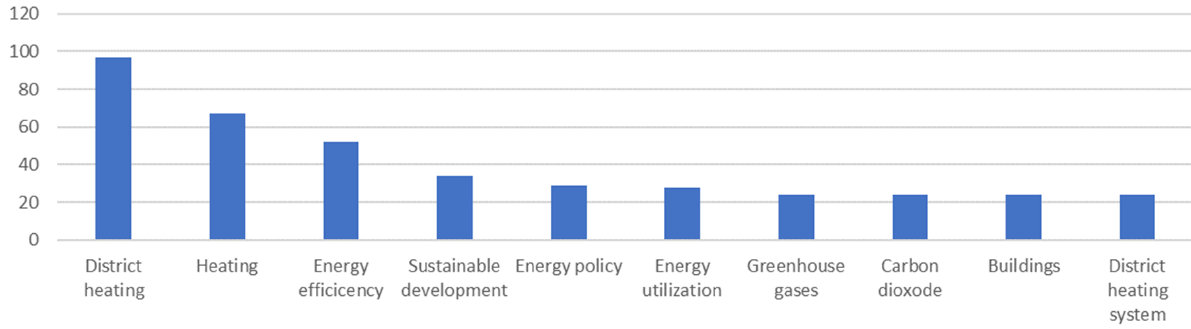
Figure 15. Impact—most frequent keywords (horizontal axis) and the number of articles (vertical axis).